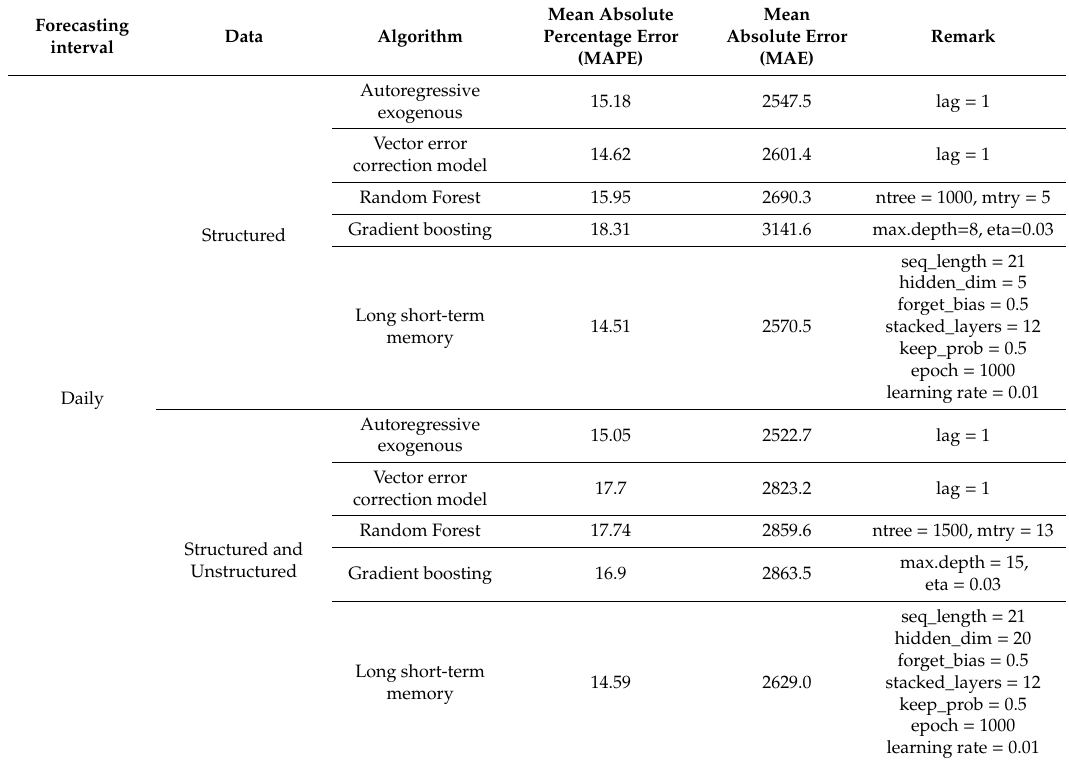
Table 4. Comparison of forecasted daily amounts to purchase pork belly meat in